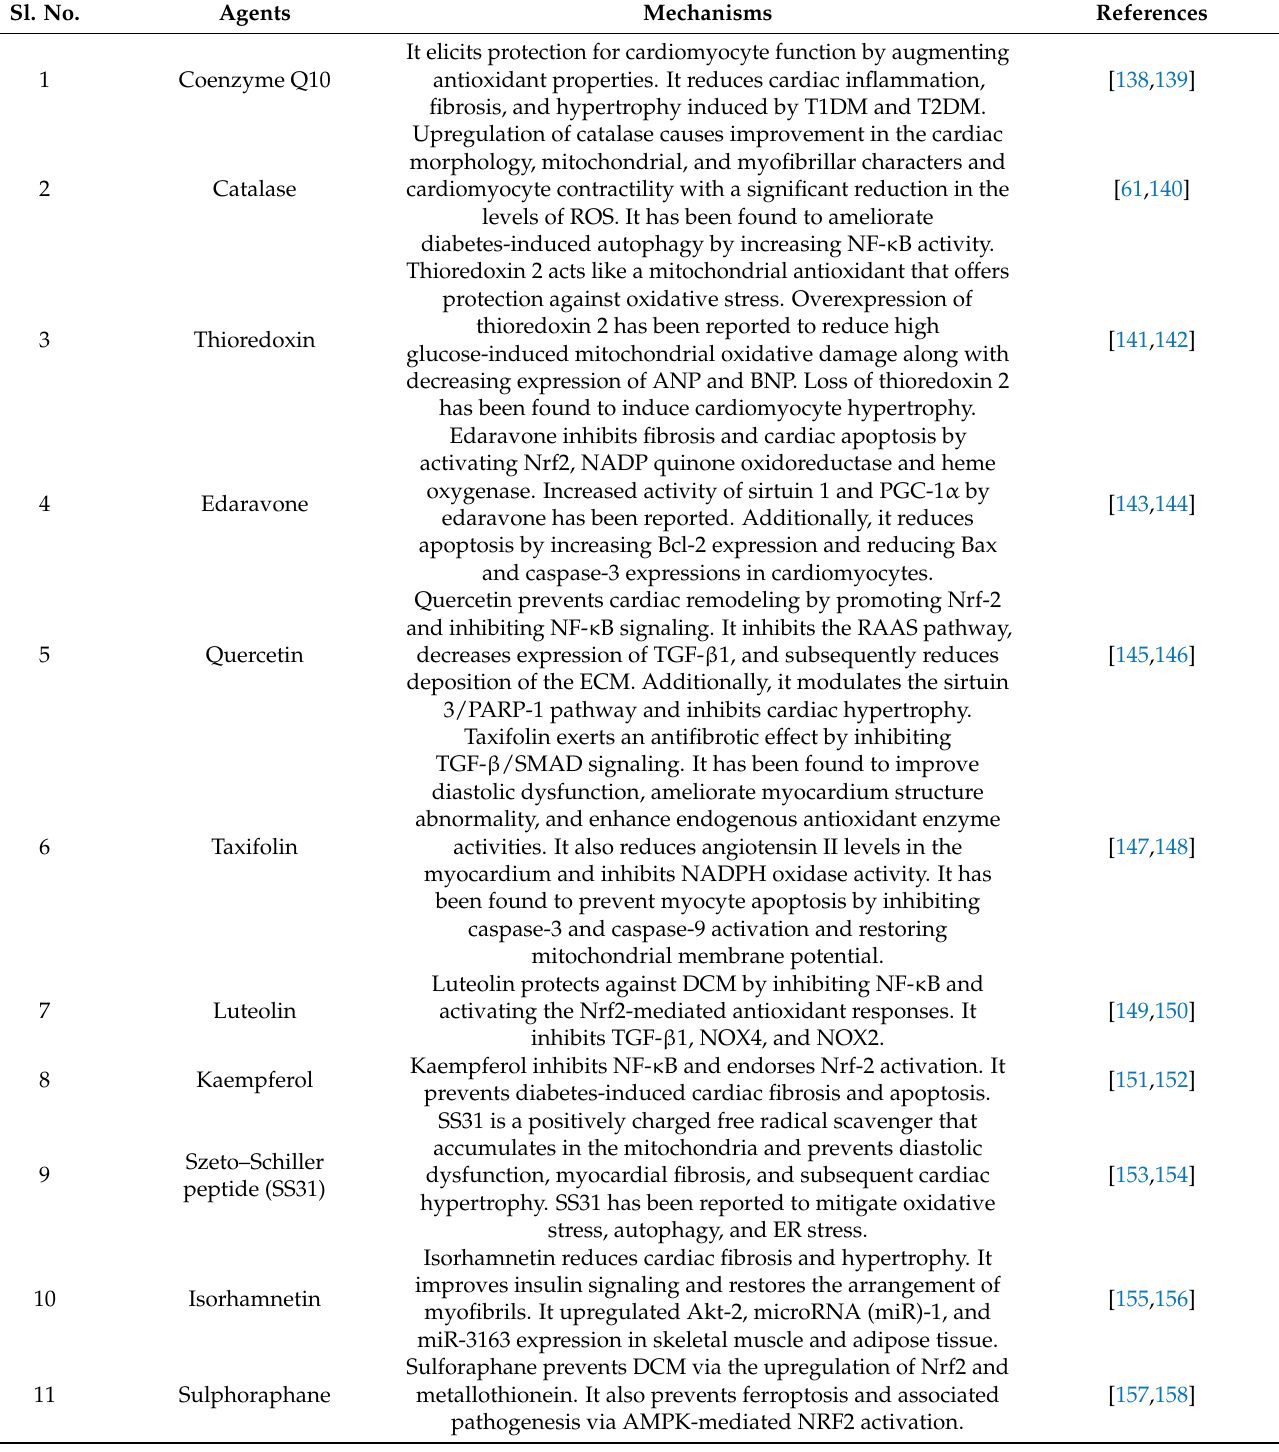
Table 1. Antioxidant strategies in the management of